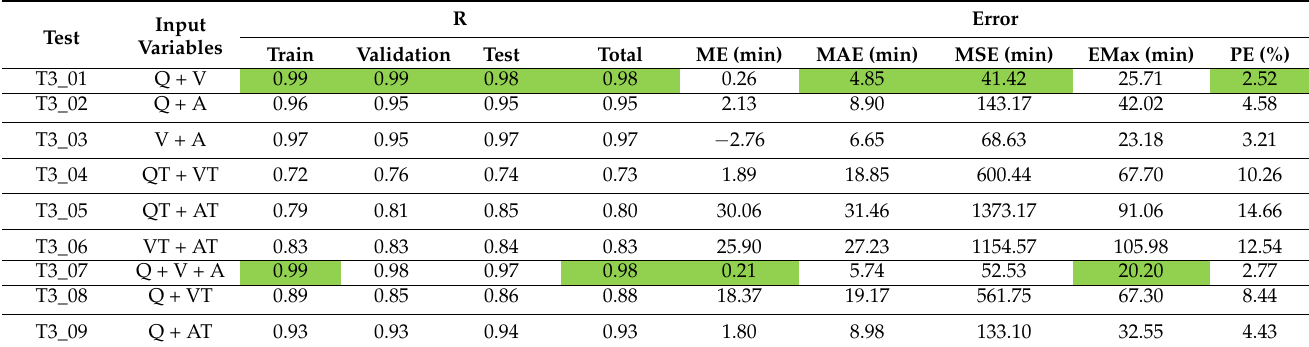
Table 5. Regression and error of the ANNs from Test